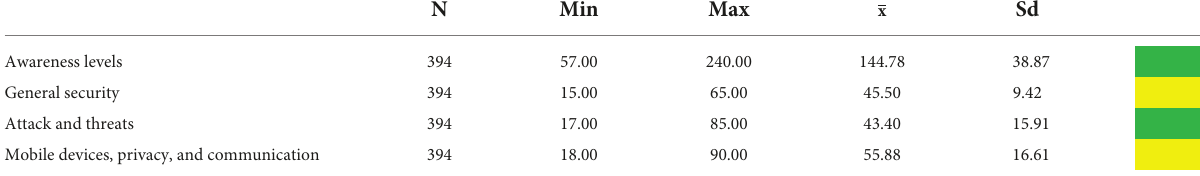
TABLE 2 Teachers’ information security awareness levels and score distribution by sub-factors.